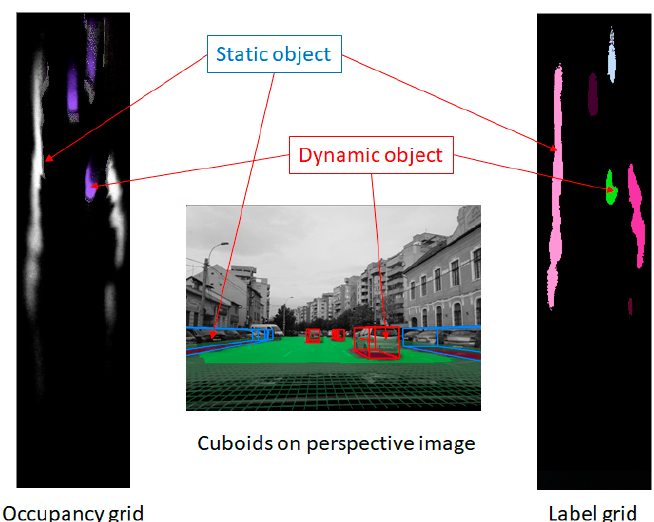
Figure 8. Identifying individual objects from the updated occupancy grid. The cells with high ‐ occupancy probability are considered for clustering (labeling). The cells that have a significant average speed of their particles are considered dynamic, and will create dynamic objects, while the others will create static objects.